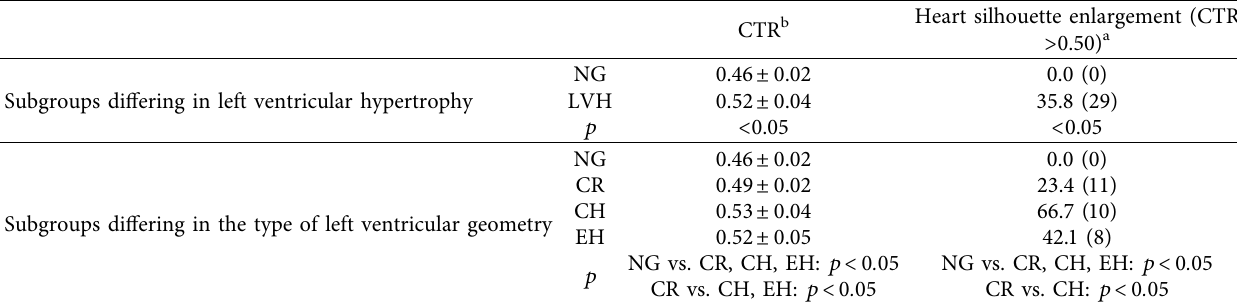
Table 4: Cardiothoracic ratio in the studied subgroups differing in the geometry of the left ventricular.